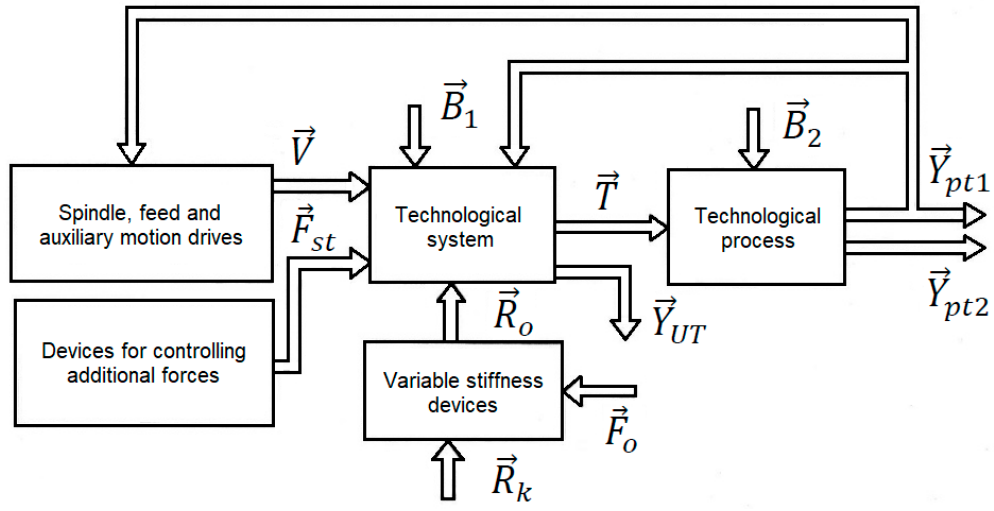
Figure 1. Schematic of a machining system for the processing of low-rigidity parts.